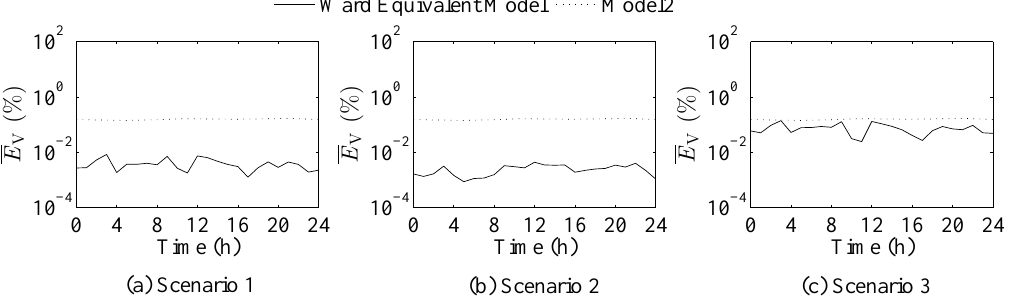
Figure 15. Mean voltage errors produced by the two models in the different